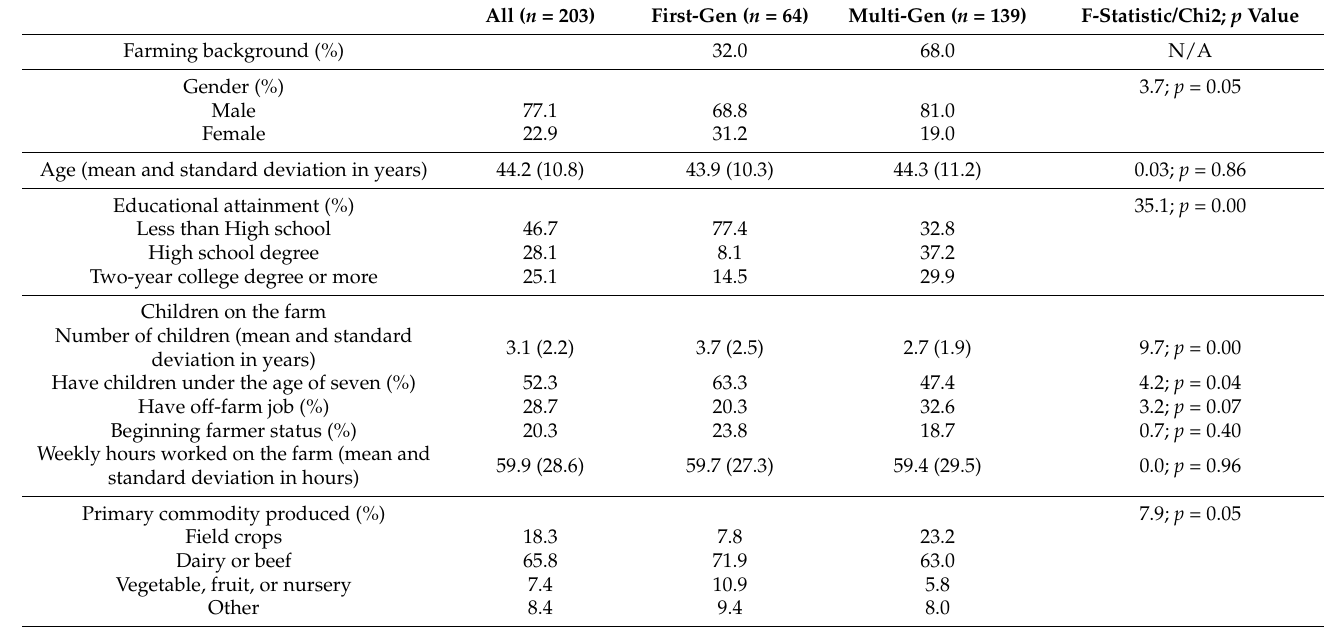
Table 3. Descriptive statistics.